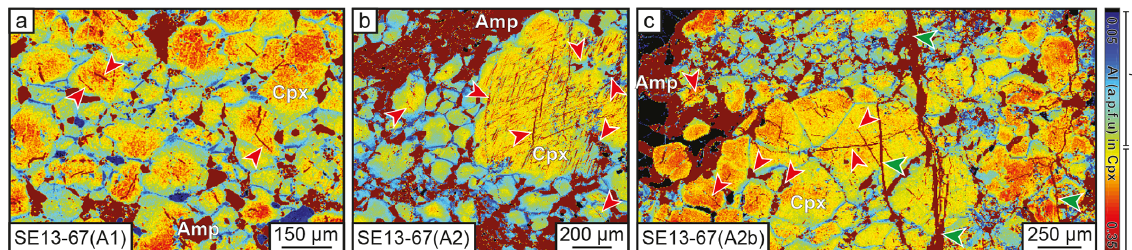
Figure 7. (a) Compositional map of Al of clinopyroxene in mono- and polymineralic layers of sample SE13-67. Red arrows point to amphibole in clinopyroxene microfractures or in interstitial positions at new clinopyroxene boundaries; Jd: jadeite content; see the text for